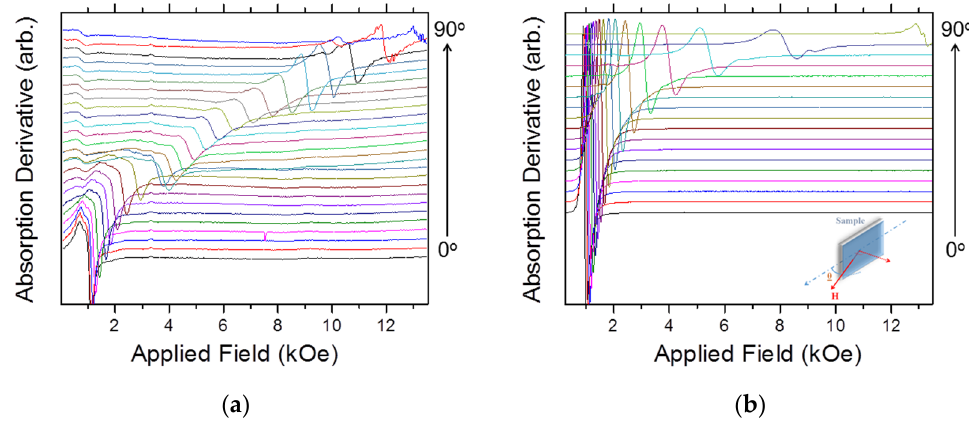
Figure 5. Ferromagnetic resonance measurements obtained as a function of out ‐ of ‐ plane angle tilting (inset) from an external DC field applied parallel to the sample plane (0°) and normal orientation (90°) for samples grown by an electrodeposition time of ( a ) 5 s and ( b ) 100 s.